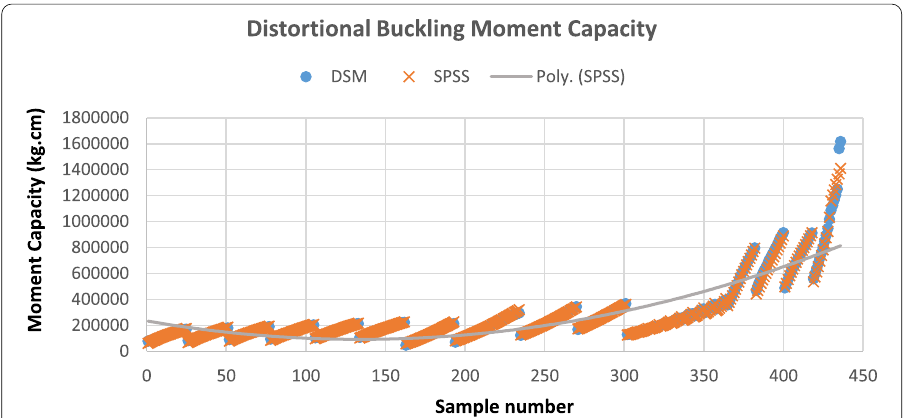
Fig. 3 Distortional buckling moment capacity calculated using DSM and proposal equation for the 436 studied